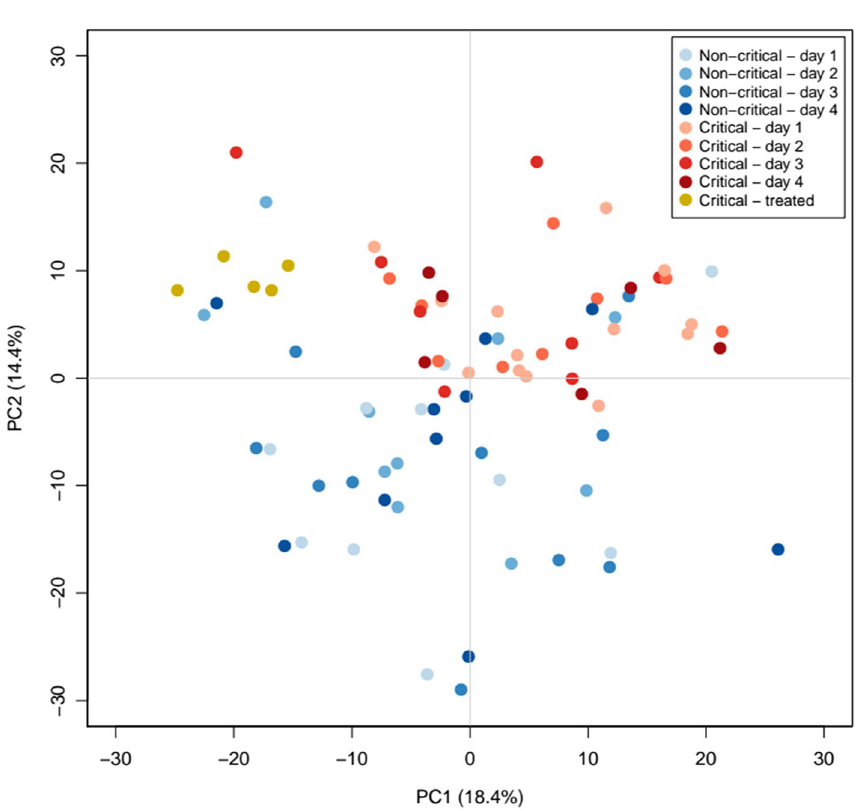
Figure 2. Principal component analysis of proteomic data at the peptide level. Dots represent the sample coordinates in principal components 1 and 2 derived from the 1.448 peptides m with available quantification for all samples in the study. Figures in the axes indicate the percentage of variance explained by the corresponding Principal Component. PC1 principal component 1. PC2 principal component 2. (Figure created using R, version 3.6.0, https:// www.R- proje ct.